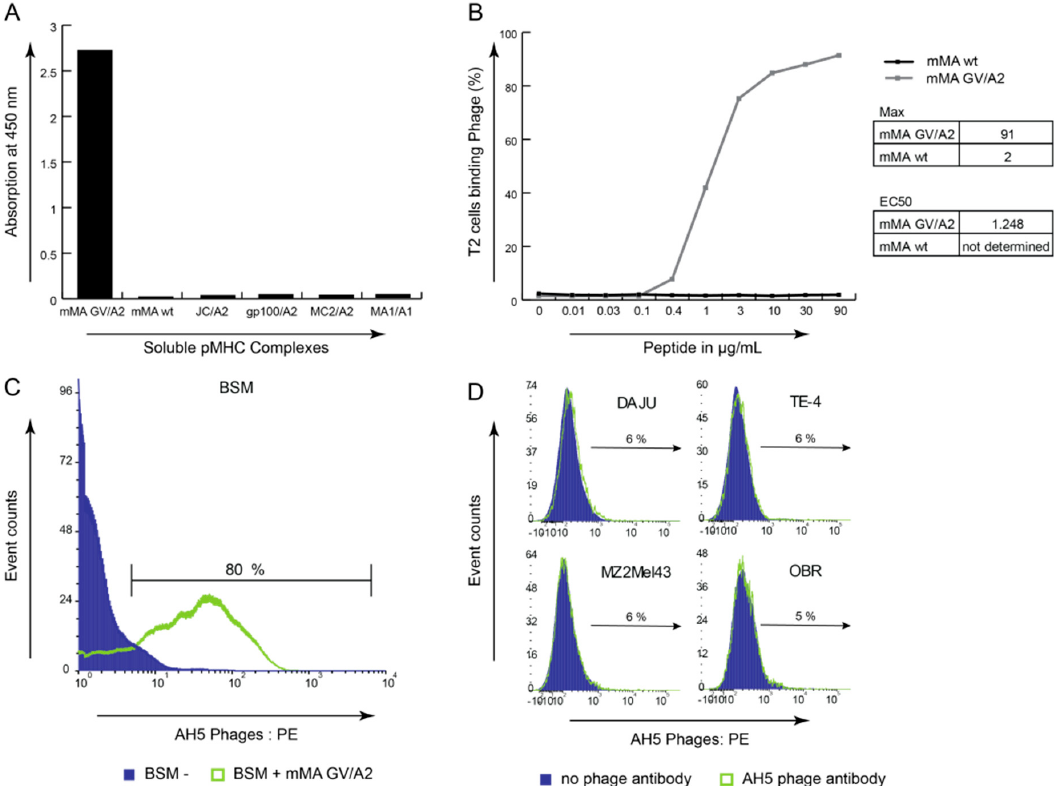
Figure 4. Anti mMA-GV/A2 phage antibody AH5 recognises heteroclitic peptide but not native mMA-wt/A2. ( A ) Phage Fab-AH5 when tested in ELISA specifically recognises mMA-GV/A2 pMHC but not irrelevant pMHC complexes. Data are presented as OD values. ( B ) Phage Fab-AH5 when tested in flow cytometry does bind to mMA-GV but not wt-pulsed T2 cells. T2 cells without external peptide served as a negative control, and data are presented as % T2 cells expressing HLA-A2. EC50 value for mMA-GV/A2 is 1.25 ug/mL or 0.95 mM; calculated by GraphPad Prism and both maximum and EC50 values are displayed. ( C ) Phage Fab-AH5 binds to mMA-GV peptide-loaded BSM cells. Data are represented as histogram overlay, purple and green lines represent HLA-A2-positive BSM cells without external peptide and mMA-GV peptide, respectively. ( D ) Phage Fab-AH5 does not bind to tumour cells expressing mMA-wt peptide. Data are represented as histogram overlays, purple and green lines represent tumour cells stained without or with phage-AH5, respectively.